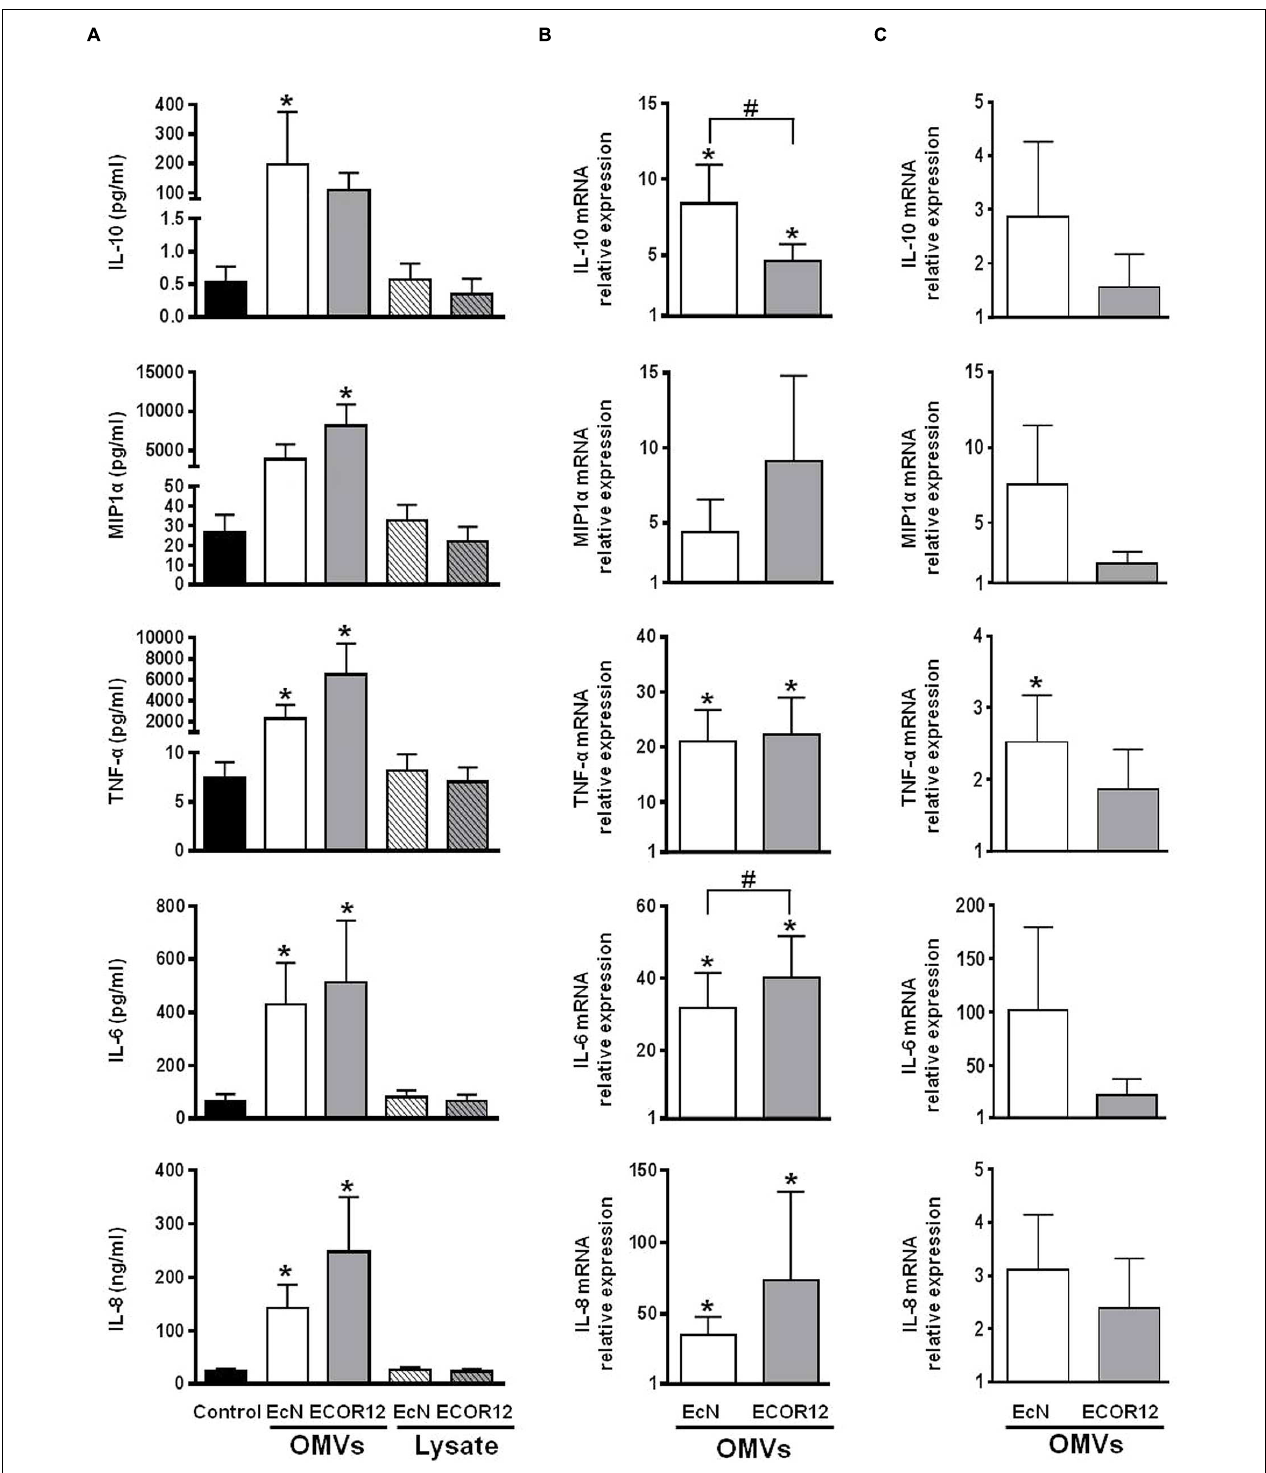
FIGURE 3 | Expression analysis of secreted cytokines and chemokines in Caco2/PBMCs co-cultures apical stimulation. The apical surface of Caco-2 monolayers was challenged by addition of OMVs or bacterial lysates from EcN or ECOR12 strains. (A) Cytokine concentration in culture supernatants after 24 h stimulation. Data are expressed as mean ± SEM. Relative gene expression levels in Caco-2 cells (B) and in PBMCs (C) after 5 h stimulation with OMVs. Data are presented as fold-change compared to untreated control cells. Statistical differences were assessed by the t -test or by the non-parametric Mann–Whitney U -test. ∗ p ≤ 0.05, versus control cells; # p ≤ 0.05, between cells treated with OMVs from EcN or ECOR12.